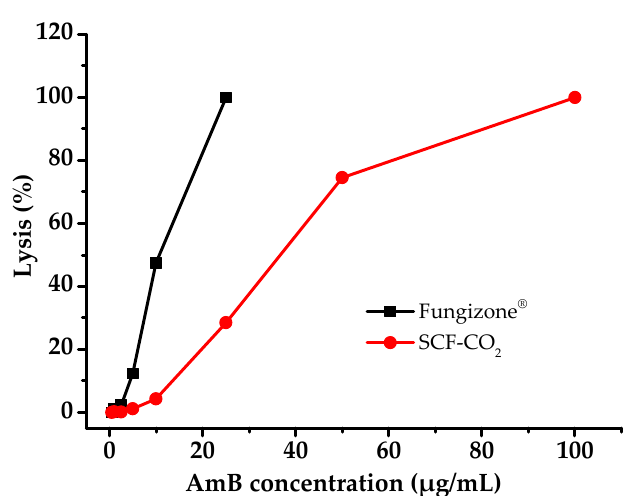
Figure 8. Hemolysis of rat RBCs at various concentrations of AmB as Fungizone ® and liposomal AmB prepared by the SCF-CO 2 process.